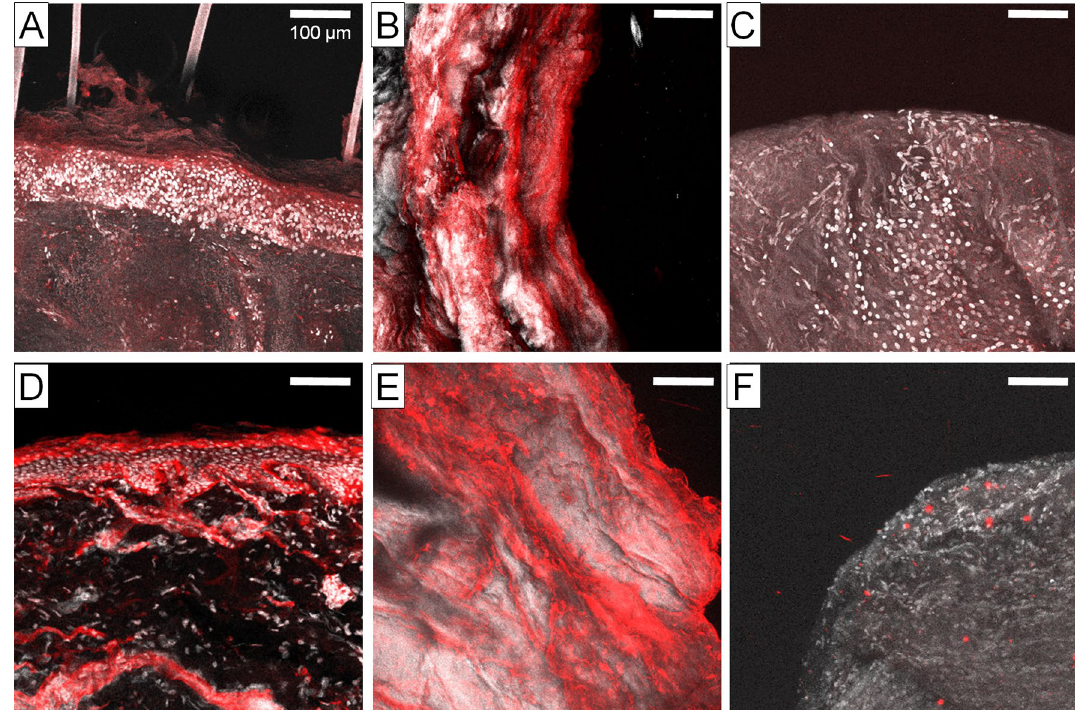
Figure 3. Cet-BPD PIC selectively localizes to human cholesteatoma and skin. ( A ) Cet-BPD PIC localizes to the epidermal region of fresh human skin, and ( B ) fresh human cholesteatoma tissue, but not ( C ) fresh middle ear mucosa tissue. ( D ) Cet-AF647 applied to epidermal region of fixed human skin, ( E ) fixed cholesteatoma tissue, and ( F ) fixed middle ear mucosa tissue confirms the pattern observed with Cet-BPD applied to fresh